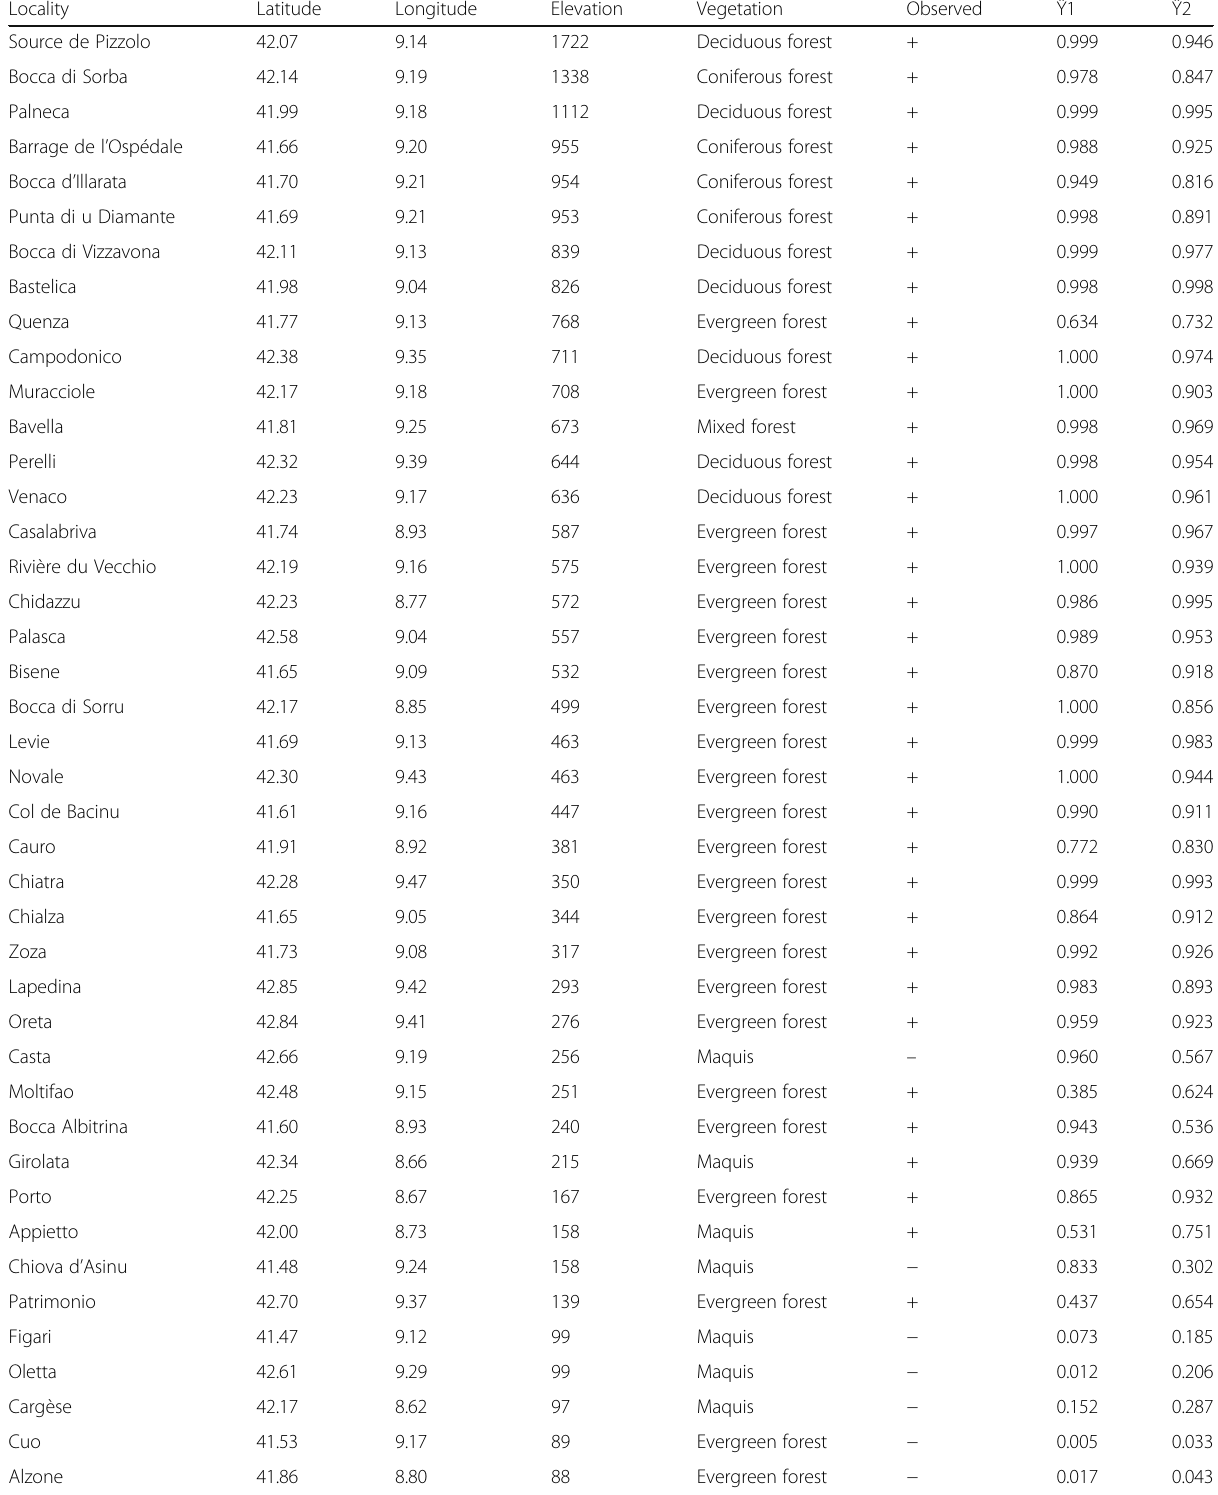
Table 3 Predicted probabilities for the presence/absence sites using random forest classification. Observed (+) = Salamandra corsica presence site; Observed ( − ) = Salamandra corsica absence site. Ŷ 1 = macro-ecological model; Ŷ 2 = mixed model. Datum for all coordinates, WGS84. Elevation,